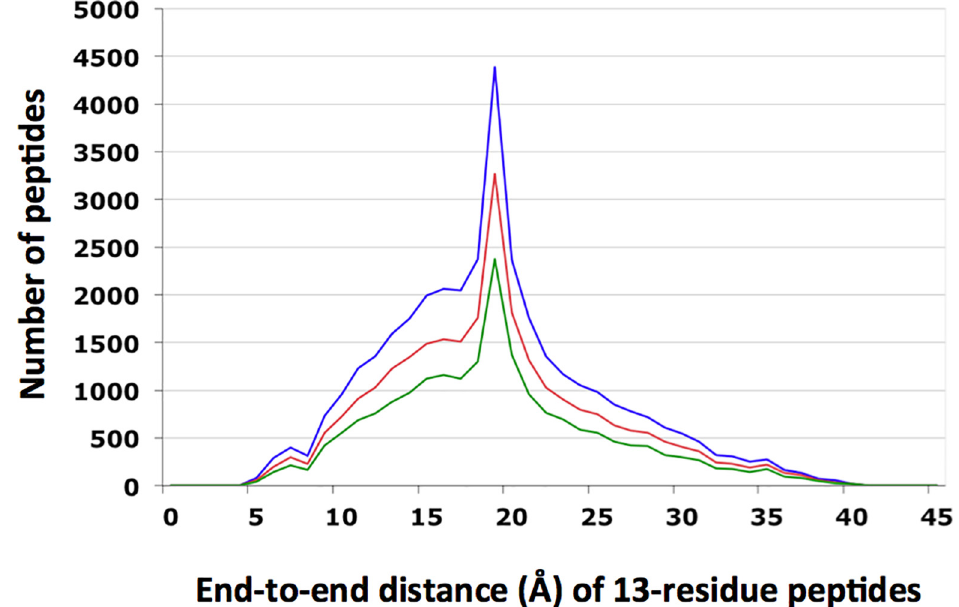
Fig 7. Histograms of the end-to-end distances of 13-residue peptides in protein structures in PDB, using only those peptides with the Blosum62 score greater than 8 (blue), 9 (red) or 10 (green) when compared to the linker sequence (shown in Box in Fig 1B) in